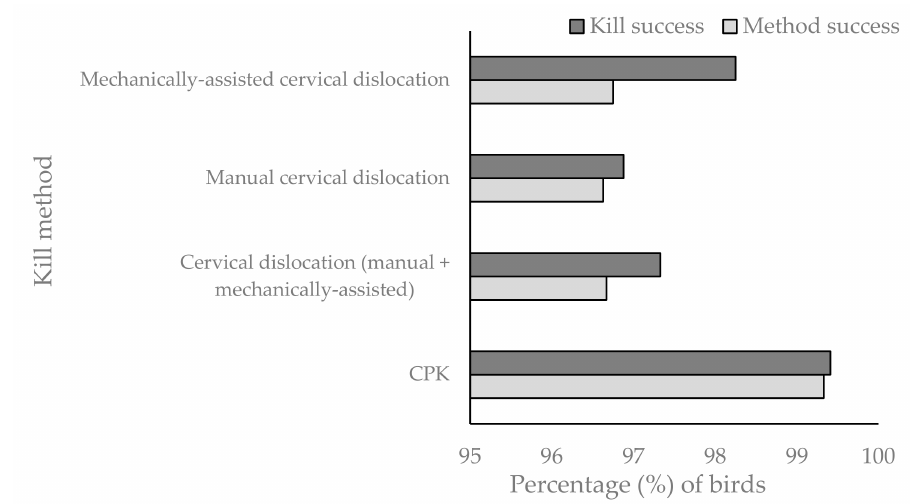
Figure 2. Bar chart providing a comparison between the percentage of birds successfully killed (kill success = single kill attempt resulting in rapid death) and the percentage of birds where the method application was optimal (method success = single kill attempt resulting in rapid death and optimal anatomical damage) for each kill method (CPK ( n = 1200 birds), cervical dislocation (manual + mechanically-assisted) ( n = 1200 birds), manual cervical dislocation alone ( n = 800 birds), and mechanically-assisted cervical dislocation alone ( n = 400 birds). Note that the Y axis scale starts at